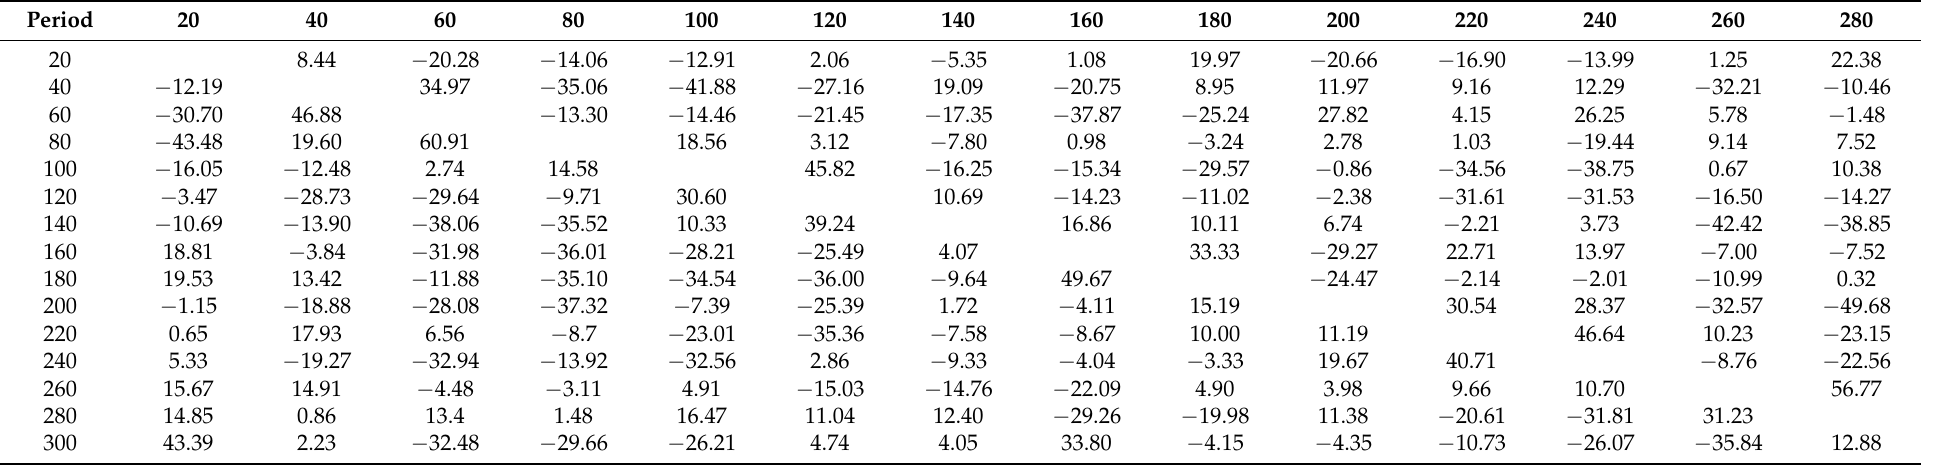
Table 5. Pearson correlation coefficients r ( × 100) between spread rates. Above the diagonal, consecutive nonoverlapping 20-day periods from the USA (Table 3), and, below the diagonal, from various countries (Table 4). Highlights are for p < 0.05, two-tailed